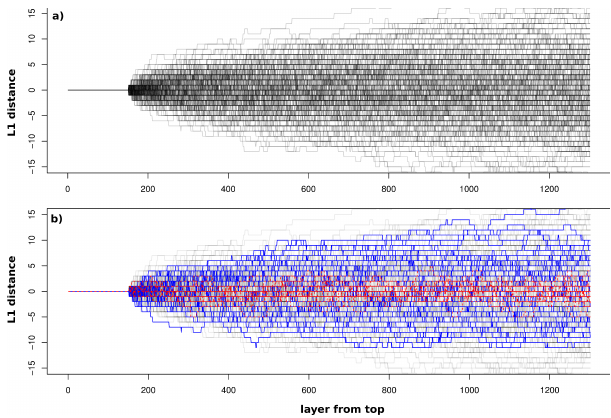
Figure 1. Trace plots of ADMs used in Sect. 4.1. Shown is the mis- match of layer number (experimental date) vs. true date, for each of the ensemble of ADMs. A perfect ADM would be a straight hor- izontal line at zero. (a) All ADMs. (b) All ADMs (black), ADMs with posterior probability > prior probability (blue), 20 ADMs clos- est to target